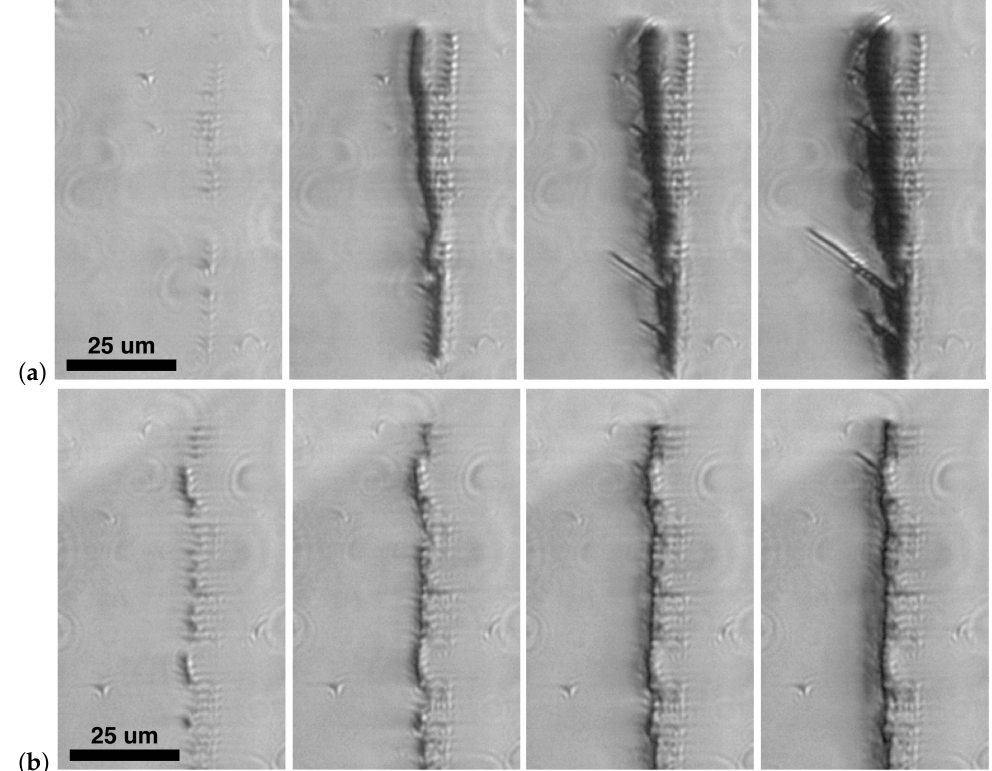
Figure 3. The stages of seed-based laser writing in diamond: ( a ) seed and graphitization stages with the same irradiation parameters: E s = E g = 3.0 µ J; ( b ) seed and graphitization stages with different irradiation parameters: E s = 3.0 µ J, E g = 0.8 µ J. Left to right: the seed, first, and subsequent graphitization scans. Scanning speed V s = V g = 0.2 mm/s. The focus translated from bottom to top. The laser pulses propagated from left to